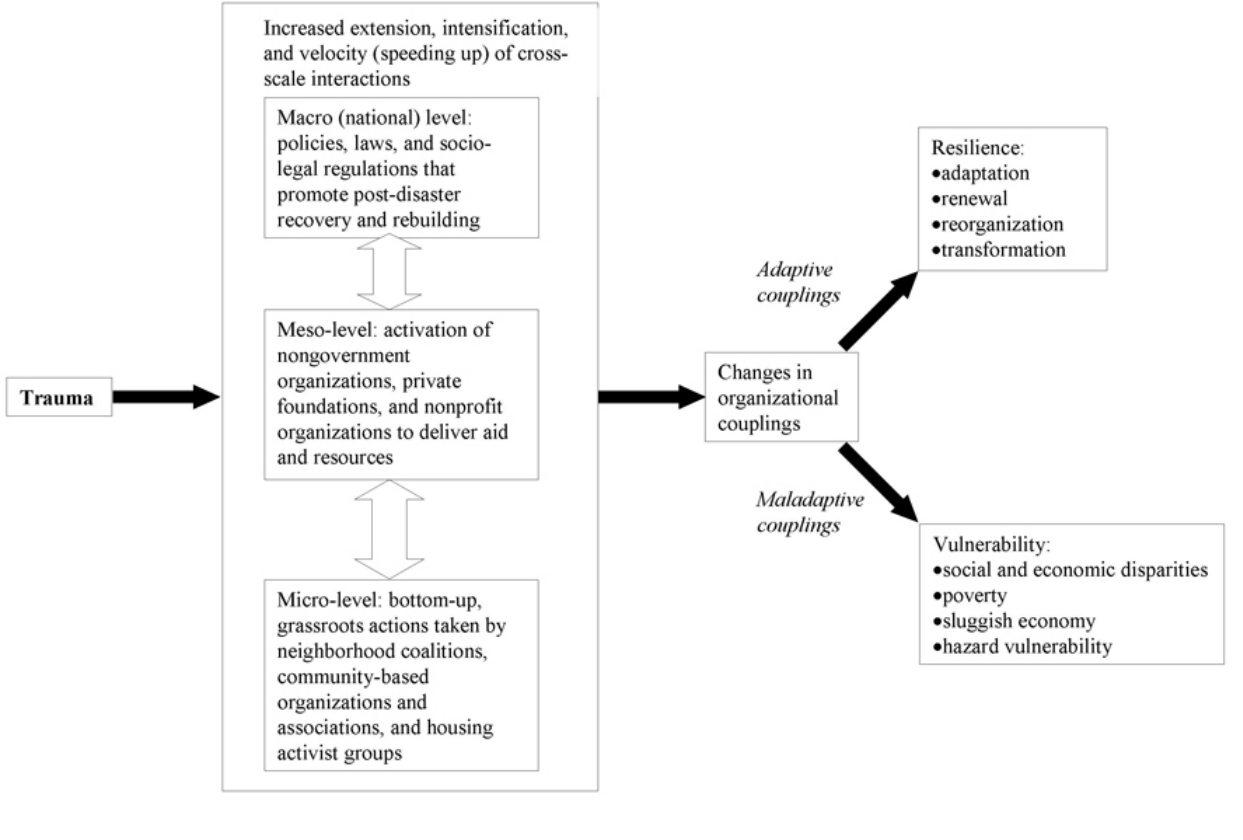
Fig. 1 . Conceptual framework for explaining the impact of trauma on social-ecological resilience and